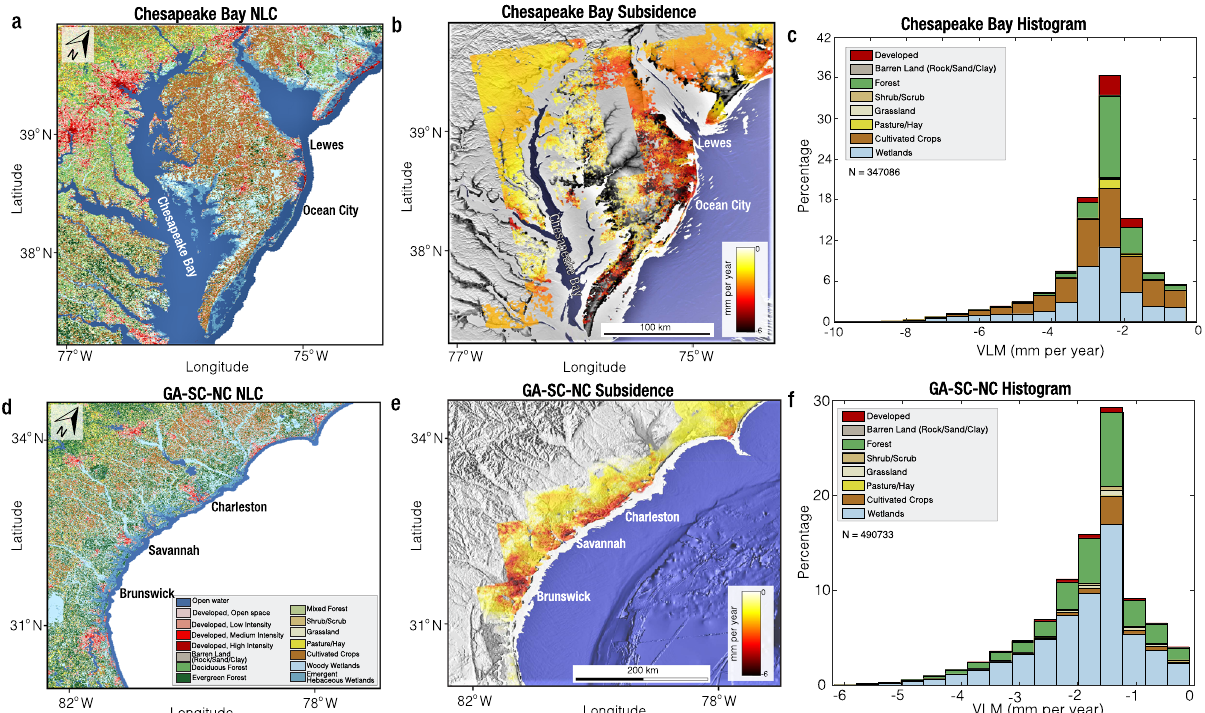
Fig. 4 | Examples of regions with signi fi cant exposure to land subsidence. a Nationallandcover(NLC)mapfortheChesapeakeBayarea 29 . b LandSubsidence across the Chesapeake Bay area. Background is the global multi-resolution topo- graphy (GMRT) made with GeoMapApp (www.geomapapp.org) 100 . c Frequency distribution of subsidence for different NLC in the Chesapeake Bay area. The per- centage of exposure to subsidence and the average subsidence rate for the dif- ferent NLC are shown in Table 1. N is the number of pixels and VLM isvertical land